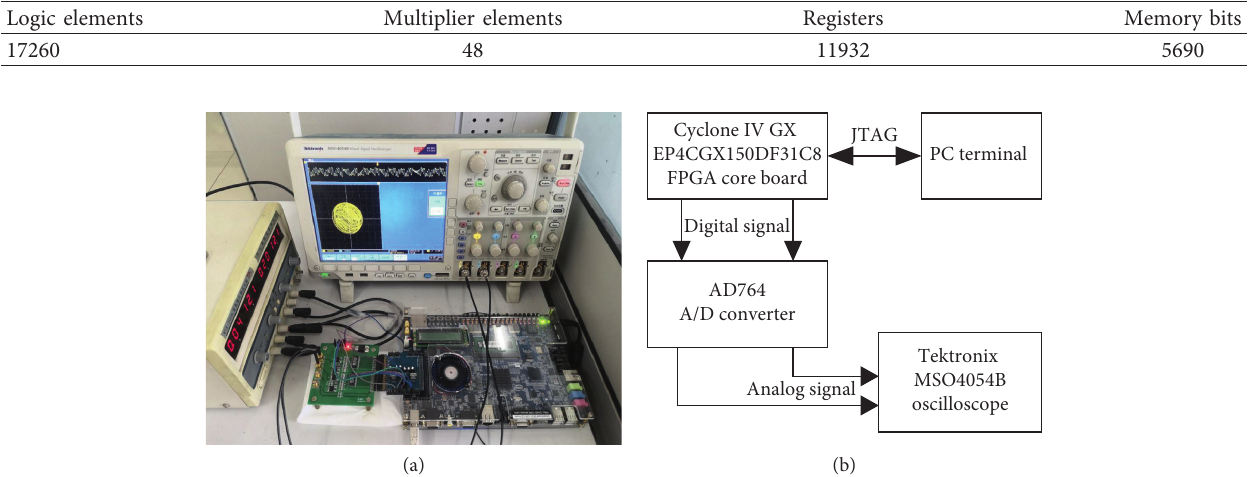
Table 4: System resource consumption.